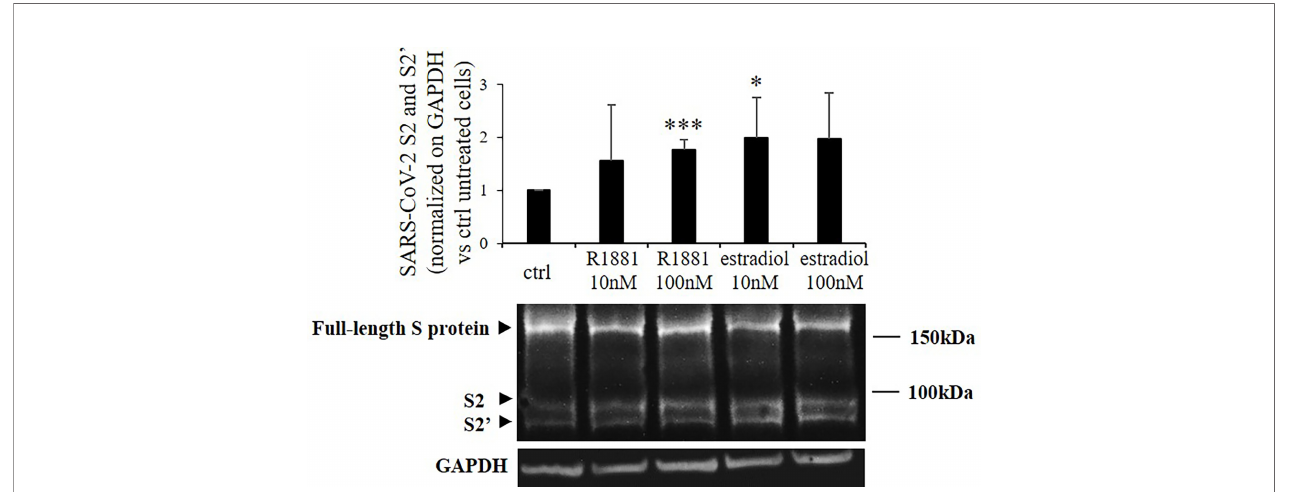
FIGURE 2 | SARS-CoV-2 Spike cleavage in response to stimulation with R1881 and estradiol. Representative Western blot image and densitometrical analysis of bands corresponding to SARS-CoV-2 Spike cleavage products (S2 and S2 ’ ) in Calu-3 cells transfected with SARS-CoV-2 S plasmid and stimulated with the indicated concentration of R1881 and estradiol for 30 h in FBS-CSS medium. GAPDH was considered as housekeeping gene and was used for normalization. Experiments were replicated three times and results are expressed as mean ± SD. *, p < 0.05, ***, p < 0.001 vs control untreated